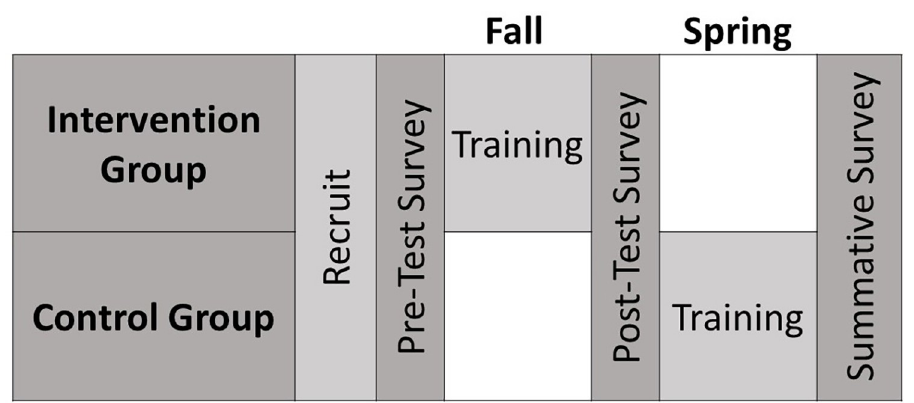
Fig 1. Timing of recruitment, training, and surveys for intervention and control groups. After recruiting participants and assigning them to either the Intervention Group or Control Group, all participants completed the Pre-Test Survey. After training of the Intervention Group all participants completed the Post-test Survey. The Summative Survey was completed by all participants after the Control Group completed